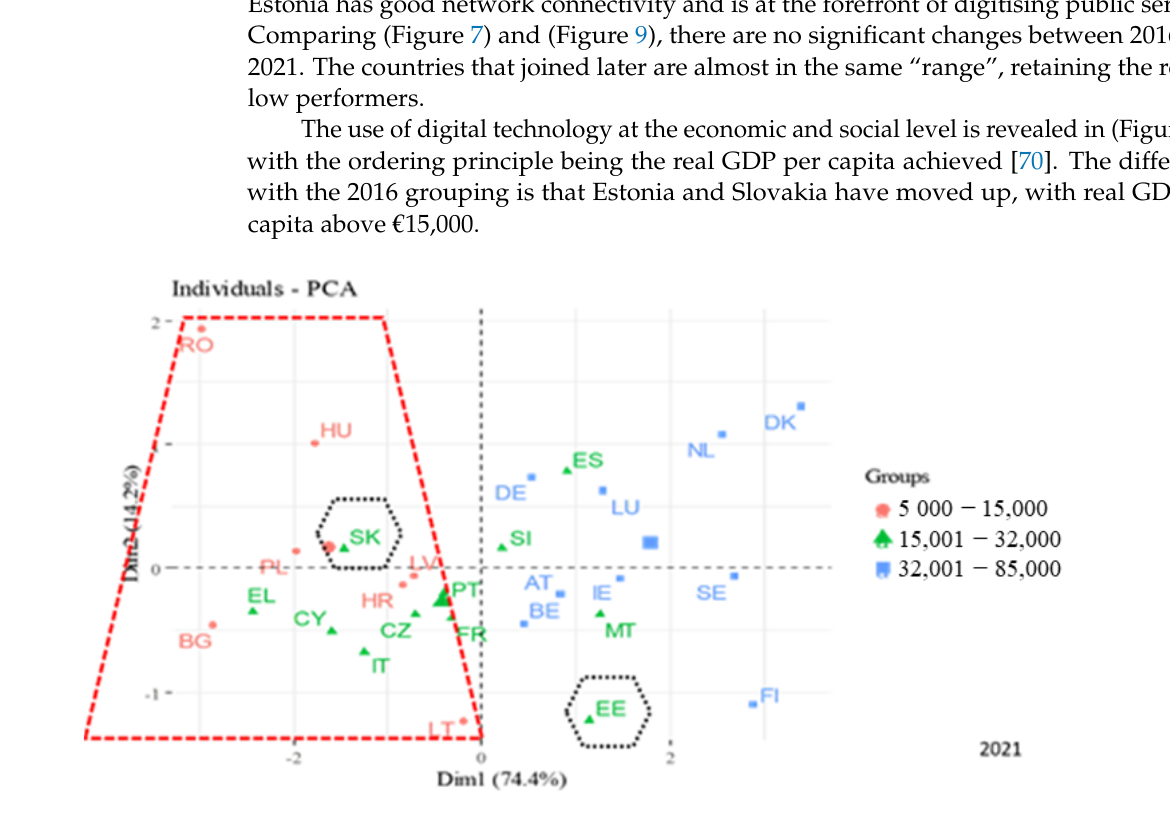
Figure 10. The position of countries on the plane of principal components (grouped by the real GDP euro per capita),